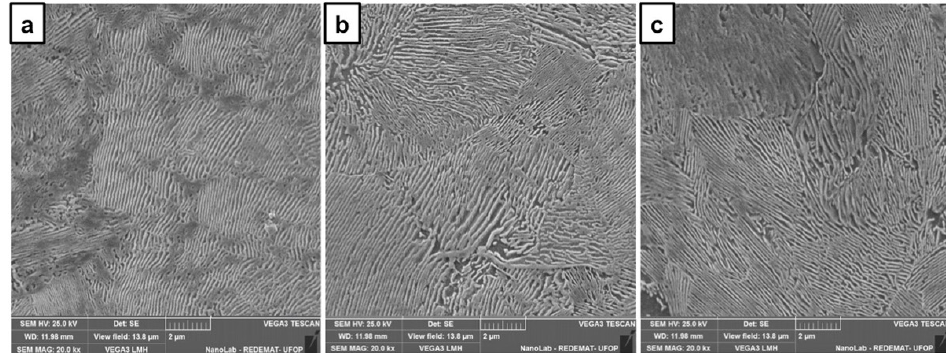
Figure 6. Micrographs of steels A (a), B (b) and C (c) submitted to 2.5°C/s cooling rate - SEM - 20.000X - 2% Nital etching.